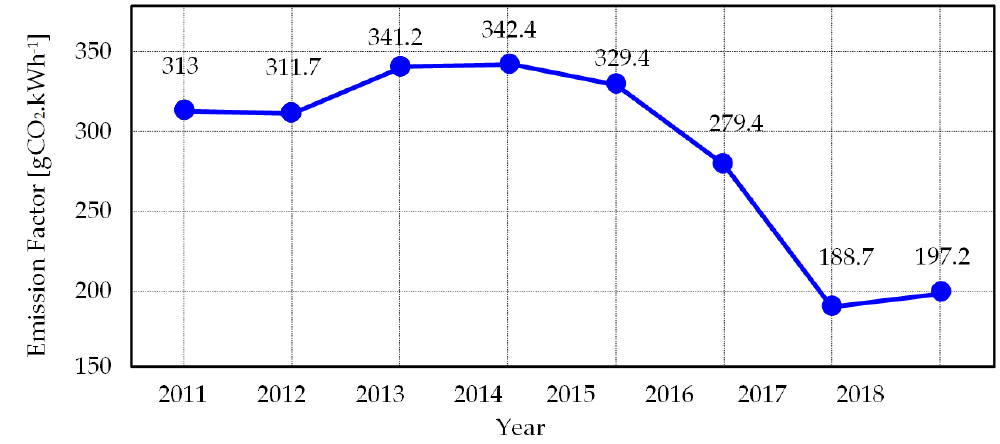
Figure 17. CO 2 emission factor (g · kWh − 1 ) for electricity generation in Ecuador.